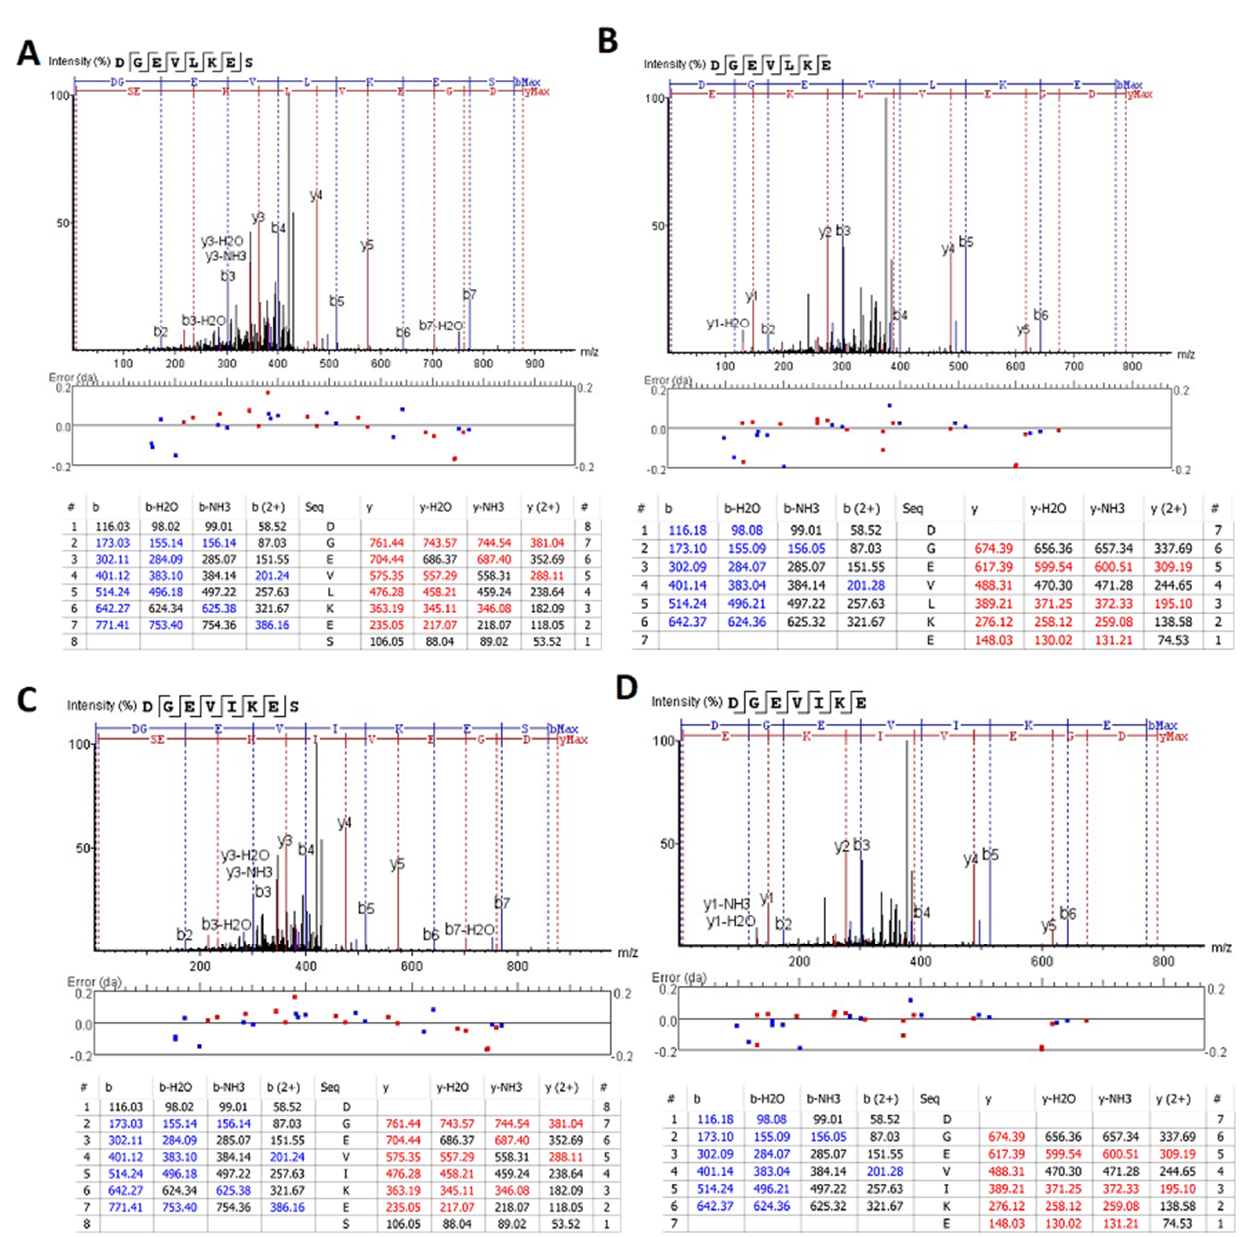
Figure 9. Unbiased LC/MS/MS followed by ( A , B ) de novo sequencing or ( C , D ) database searching both revealed GFAP peptides from pooled human acute TBI CSF samples from n = 10 samples (6–12 h post-injury): ( A , C ) DGEVIKES and ( B , D ) DGEVIKE as shown by the annotated spectra. Note: I/L are isobaric, based on the amino acid sequence for human GFAP DGEVLKES and DGEVLKE (de novo sequencing) &DGEVIKES and DGEVIKE (database searching).